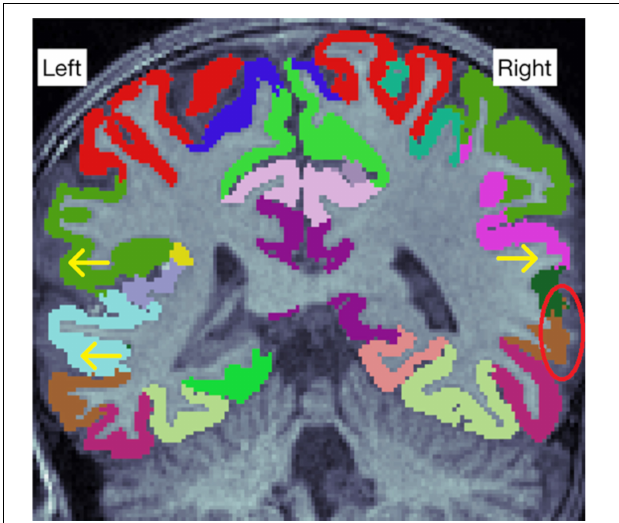
FIGURE 7 | There are some visible errors in the lateral parts of the image (arrows). An especially clear error is denoted by the red circle, where some white matter is seen outside the cortical